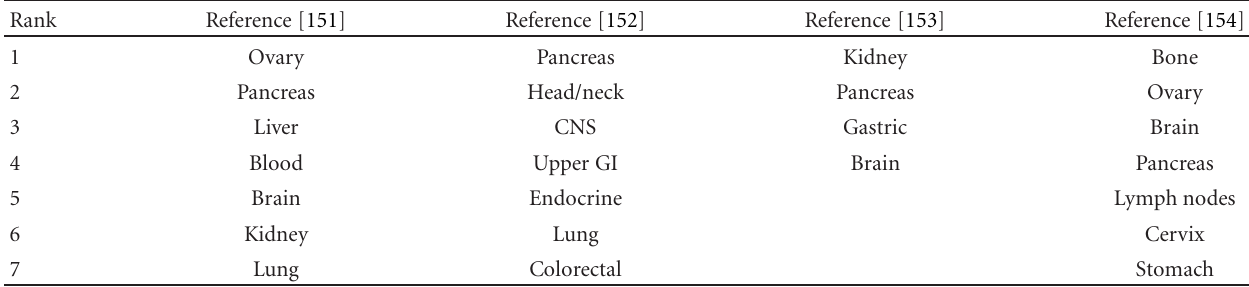
Table 3: Evidence that not all cancers are associated with the same risk of